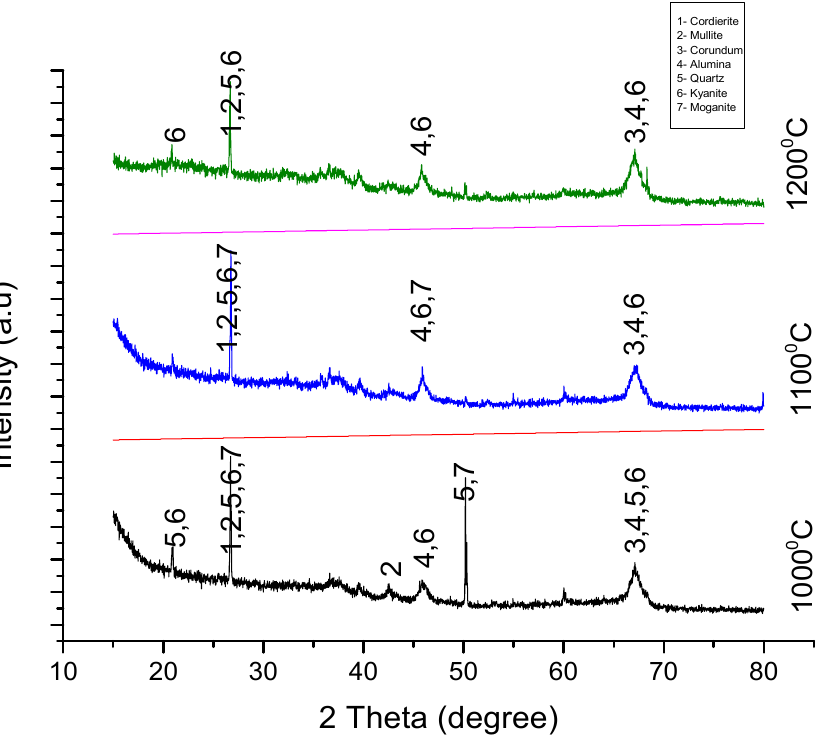
◦ C, 1100 ◦ C, and 1200 ◦